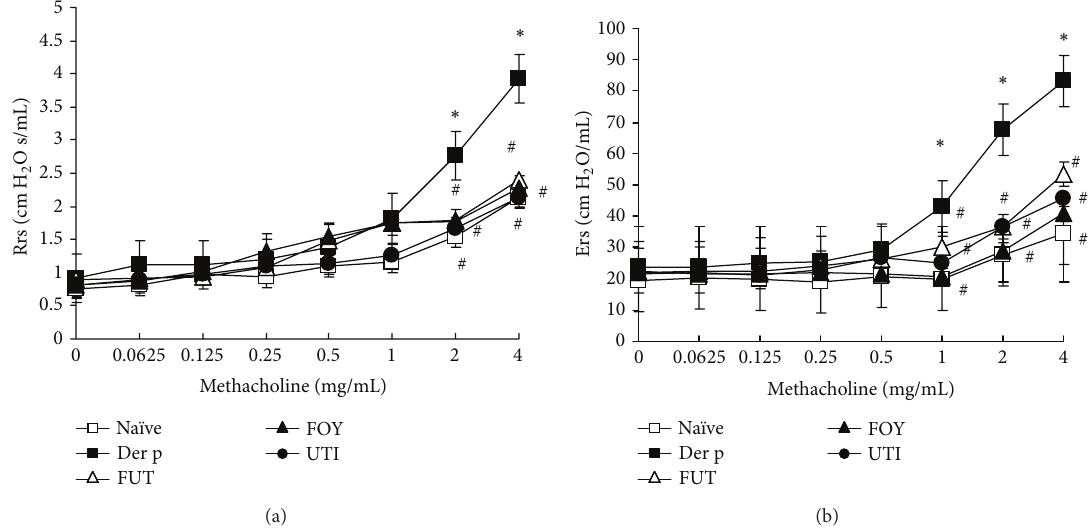
Figure 1: Effects of protease inhibitors on Der p-induced AHR. Rrs and Ers values were determined 3 days after the last Der p challenge using methacholine challenge tests (see Methods). Results are expressed as means ± SDs for 6 mice/group. ∗ 𝑃 < 0.05 versus na¨ıve group; # 𝑃 < 0.05 between Der p-treated groups.